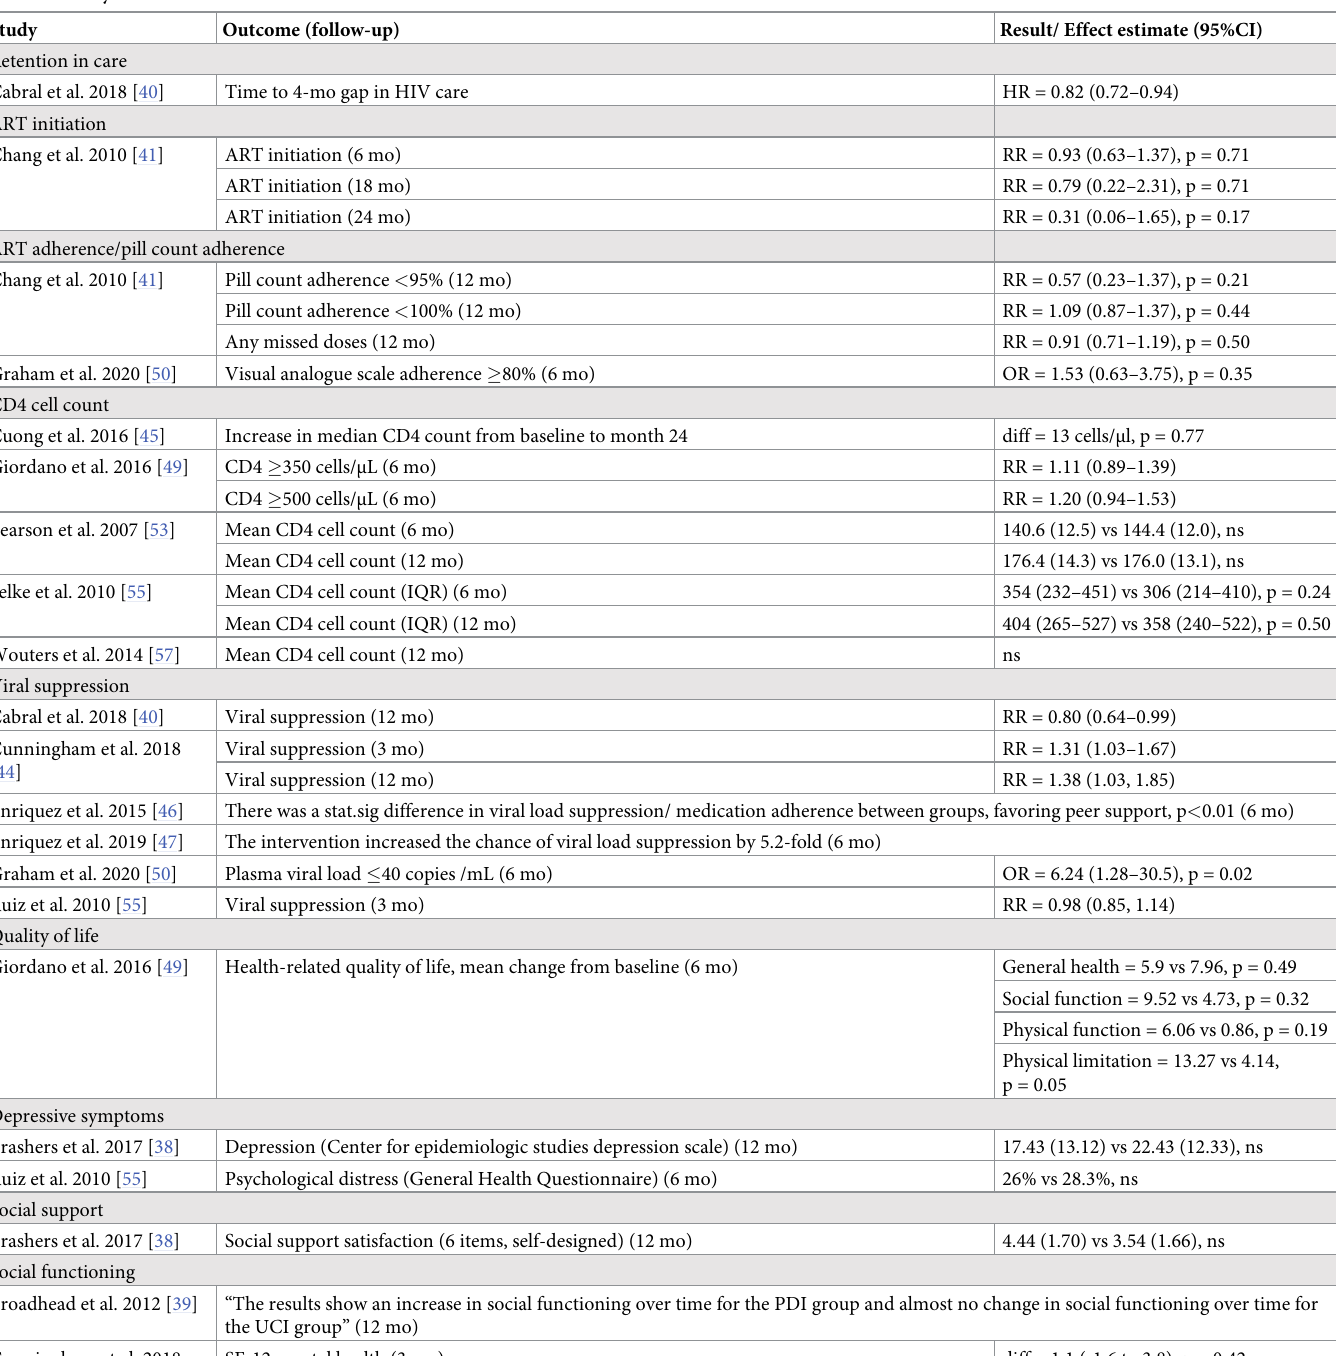
Table 2. Study outcomes and effect